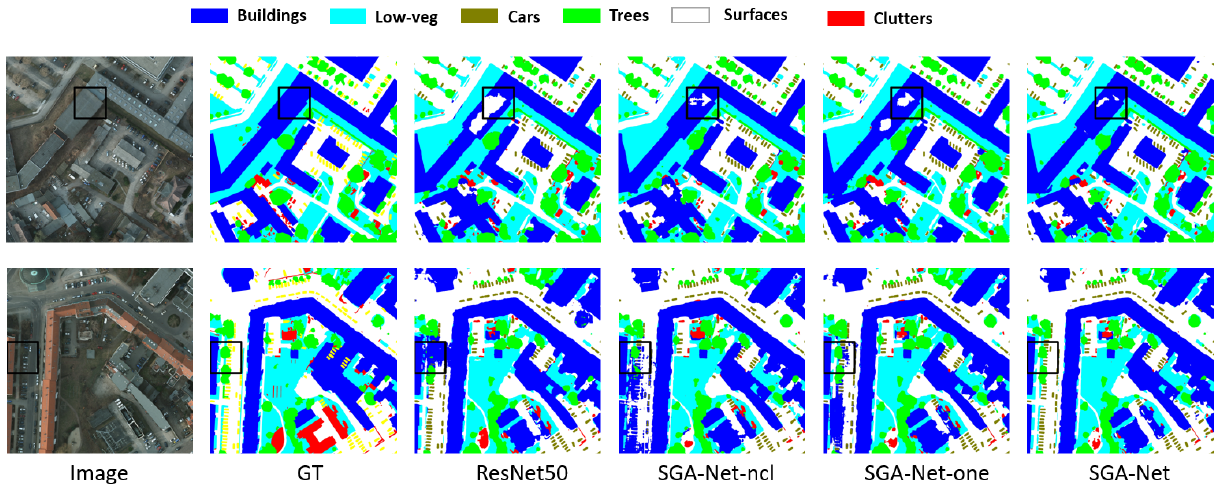
Figure 7. Visualization in the ablation study of Potsdam